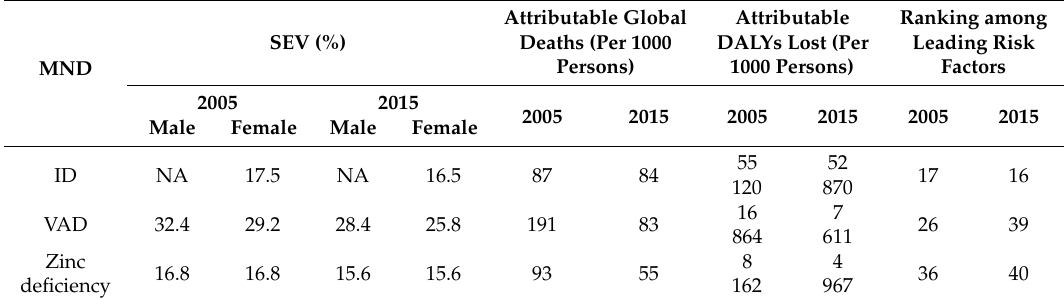
Table 1. Global age-standardized SEV, all-age deaths, DALYs attributable and ranks allocated to ID, VAD and zinc deficiency in 2005 and 2015 [6]. SEV MND